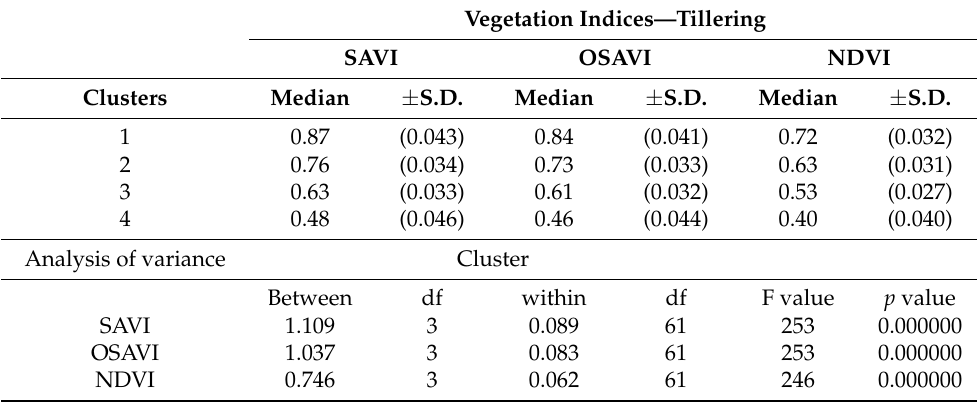
Figure 6. Map of the VIs’ spatial variability of the seven cultivars clustered by Ward’s method at tillering. Cluster 1 indicates the highest VI values, while cluster 4 indicates the lowest. Table 4. Vegetation indices’ (VIs) median values, standard deviations, and analysis of variance of clusters identified by Ward’s cluster method at tillering stage. The median values are assumed as a measure of central tendency in the case of asymmetrical data distribution.